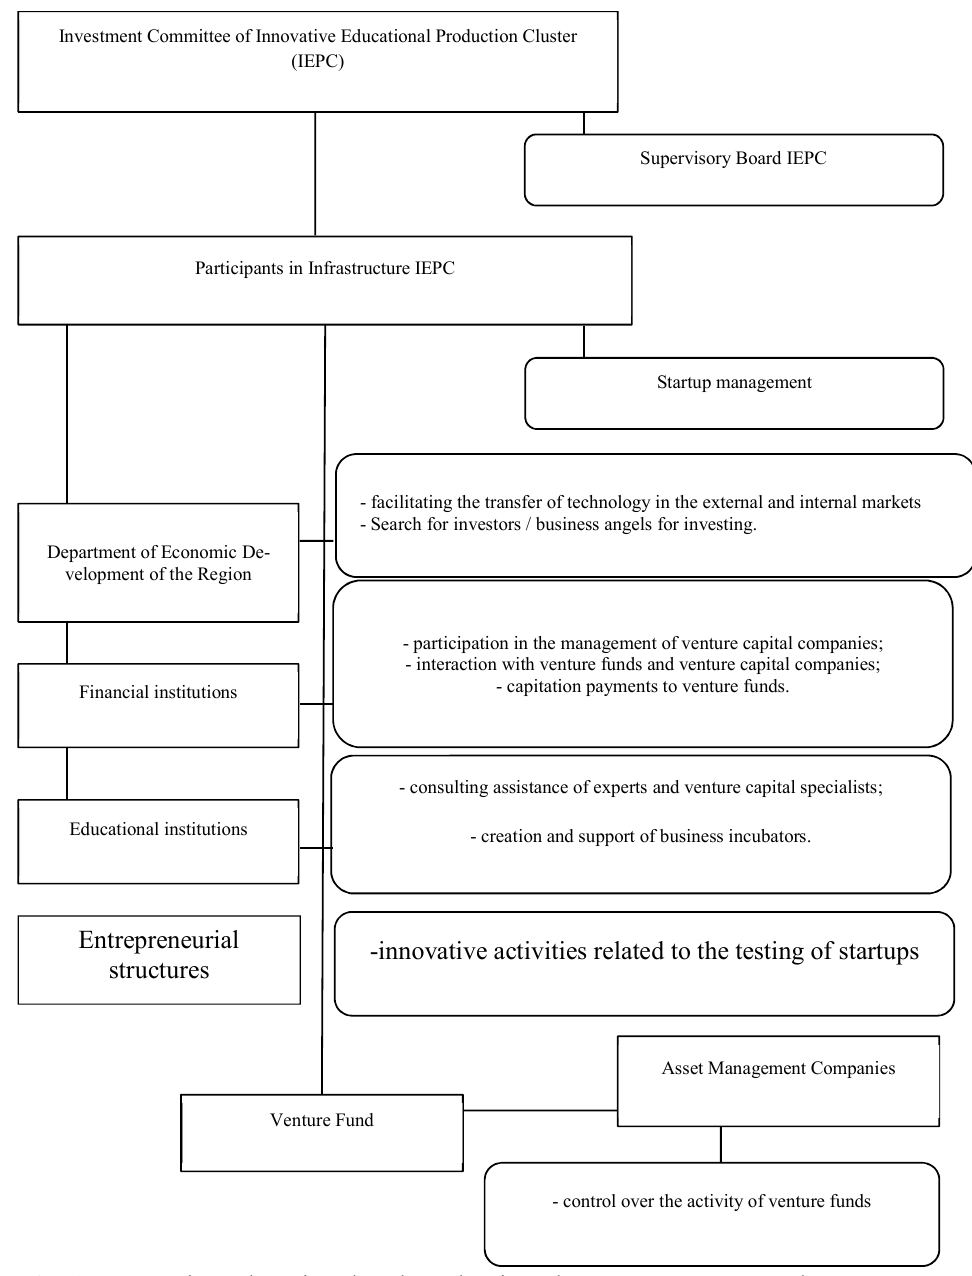
Fig. 2. Innovative educational and production cluster management scheme Source: proposed by the